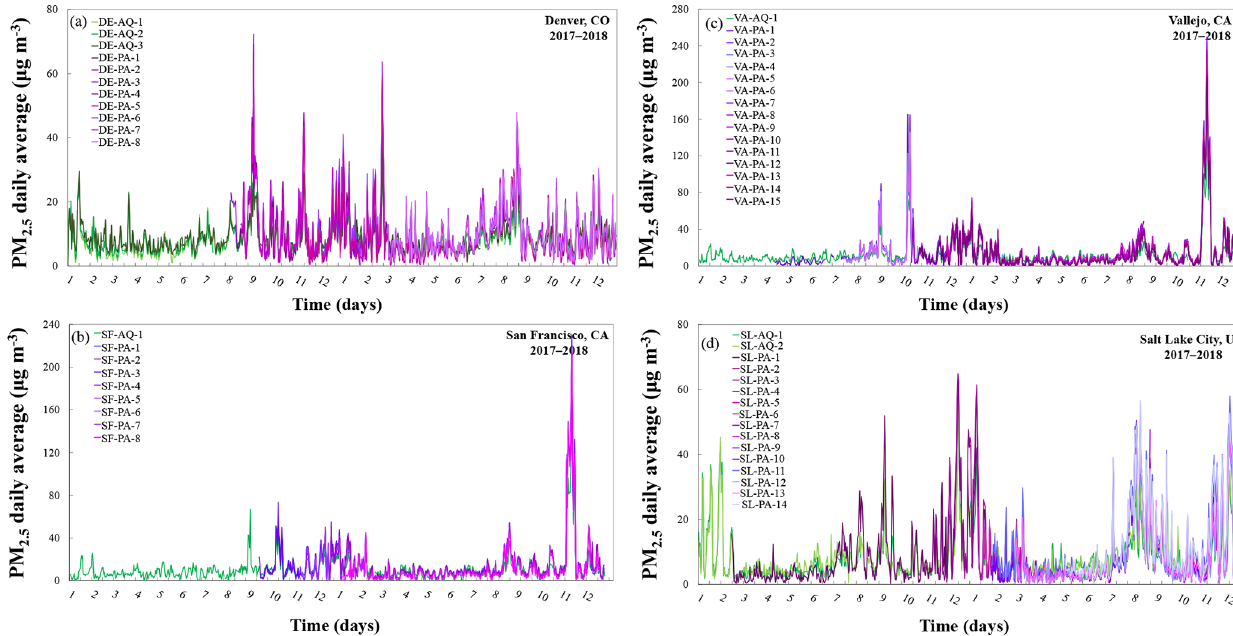
Figure 3. Time series of daily PM 2 . 5 measurements from the AQMS and PA-II units in each of the four areas: (a) Denver, (b) San Francisco, (c) Vallejo, and (d) Salt Lake City. Measurements from AQMS are represented by the green lines and the PA-II units are indicated by purple